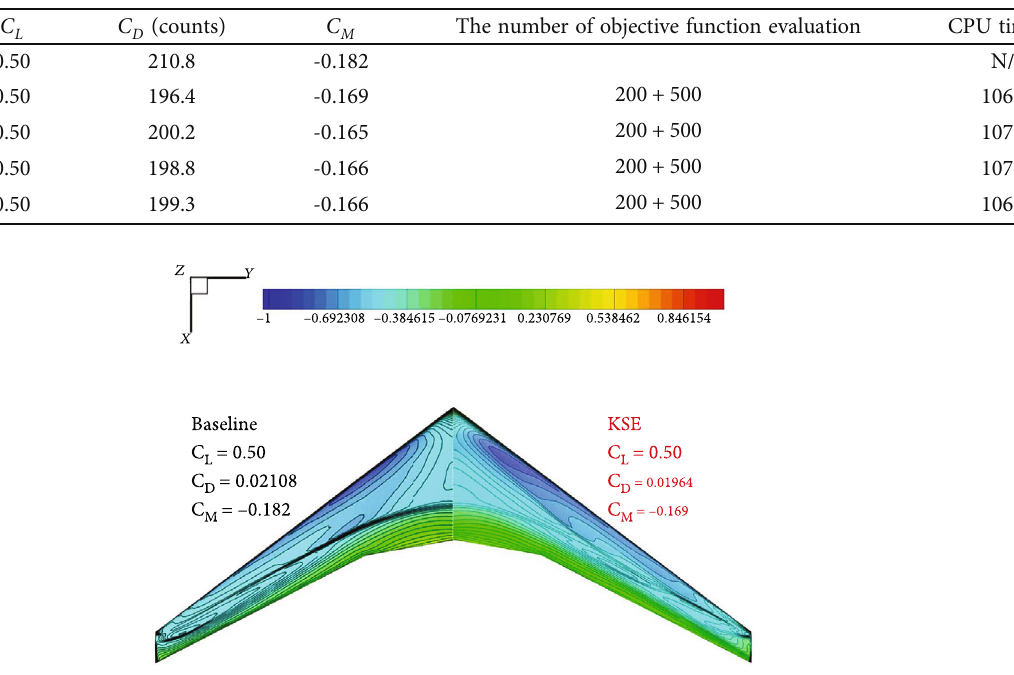
Figure 24: Pressure distributions of baseline and the KSE.